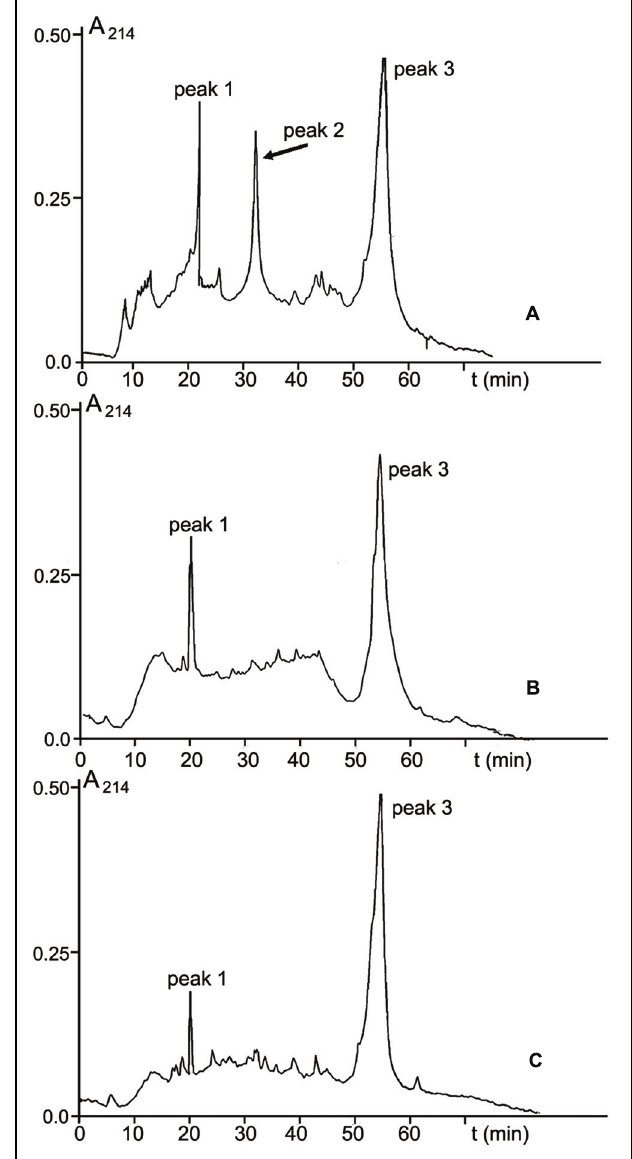
FIGURE 9 | RP-HPLC on an Aquapore C8 RP300 (4.6 mm × 100 mm) column of fractions V (A), III (B), and IV (C) obtained by SE-chromatography on Sephacryl S400 (see Figure 3). For experimental details, see section ‘Materials and Methods.’ The 10.033-Da protein is shown by an